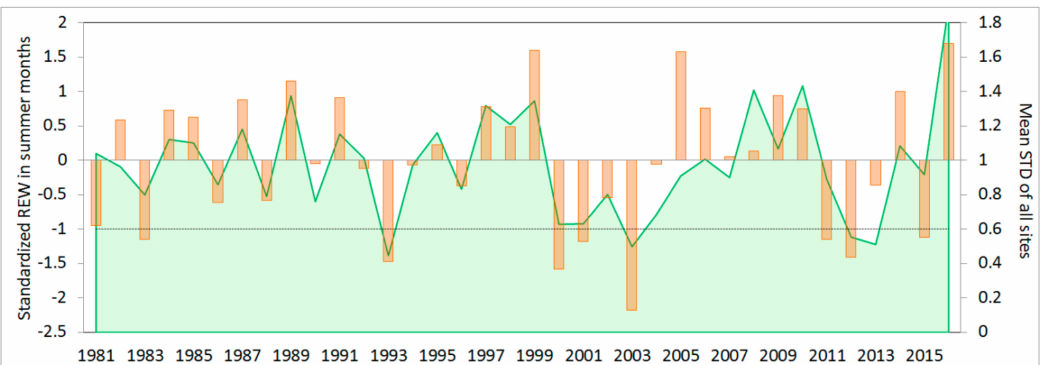
Figure 9. Standardized relative extractable water (REW) of the summer months (orange columns), with one standard deviation below the mean (dotted line) and the detrended mean standard chronology of all sites (light green